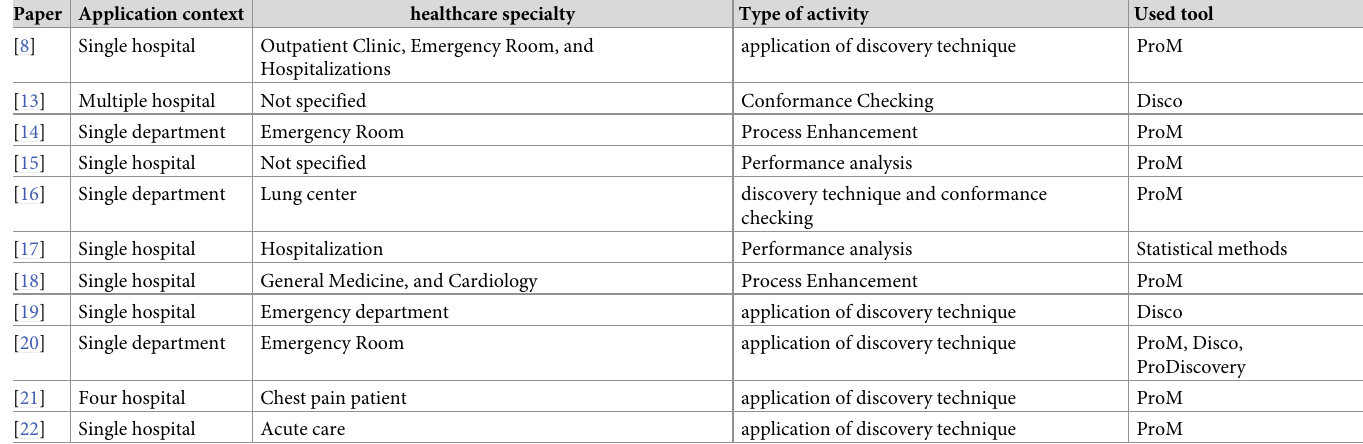
Table 1. Overview of reviewed